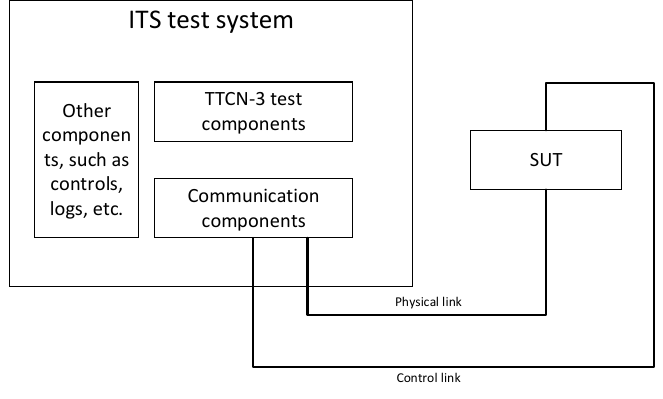
Figure 3. Abstract Test System [54].